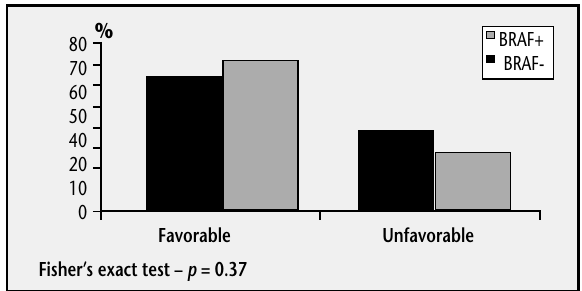
Fisher’s exact test – p = 0.37 Figura 3 – Association between clinical outcome and BRAF mutations Cumulative proportion surviving